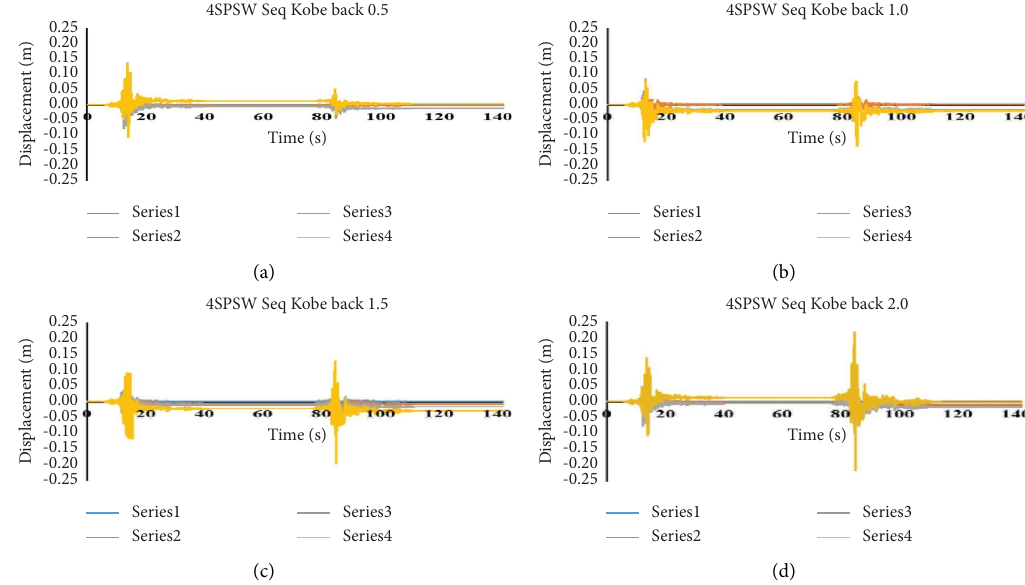
Figure 13: Time history of displacement of the 4-story model under Kobe earthquake repetitive sequence. (a) Scale 0.5, (b) scale 1, (c) scale 1.5, (d) scale